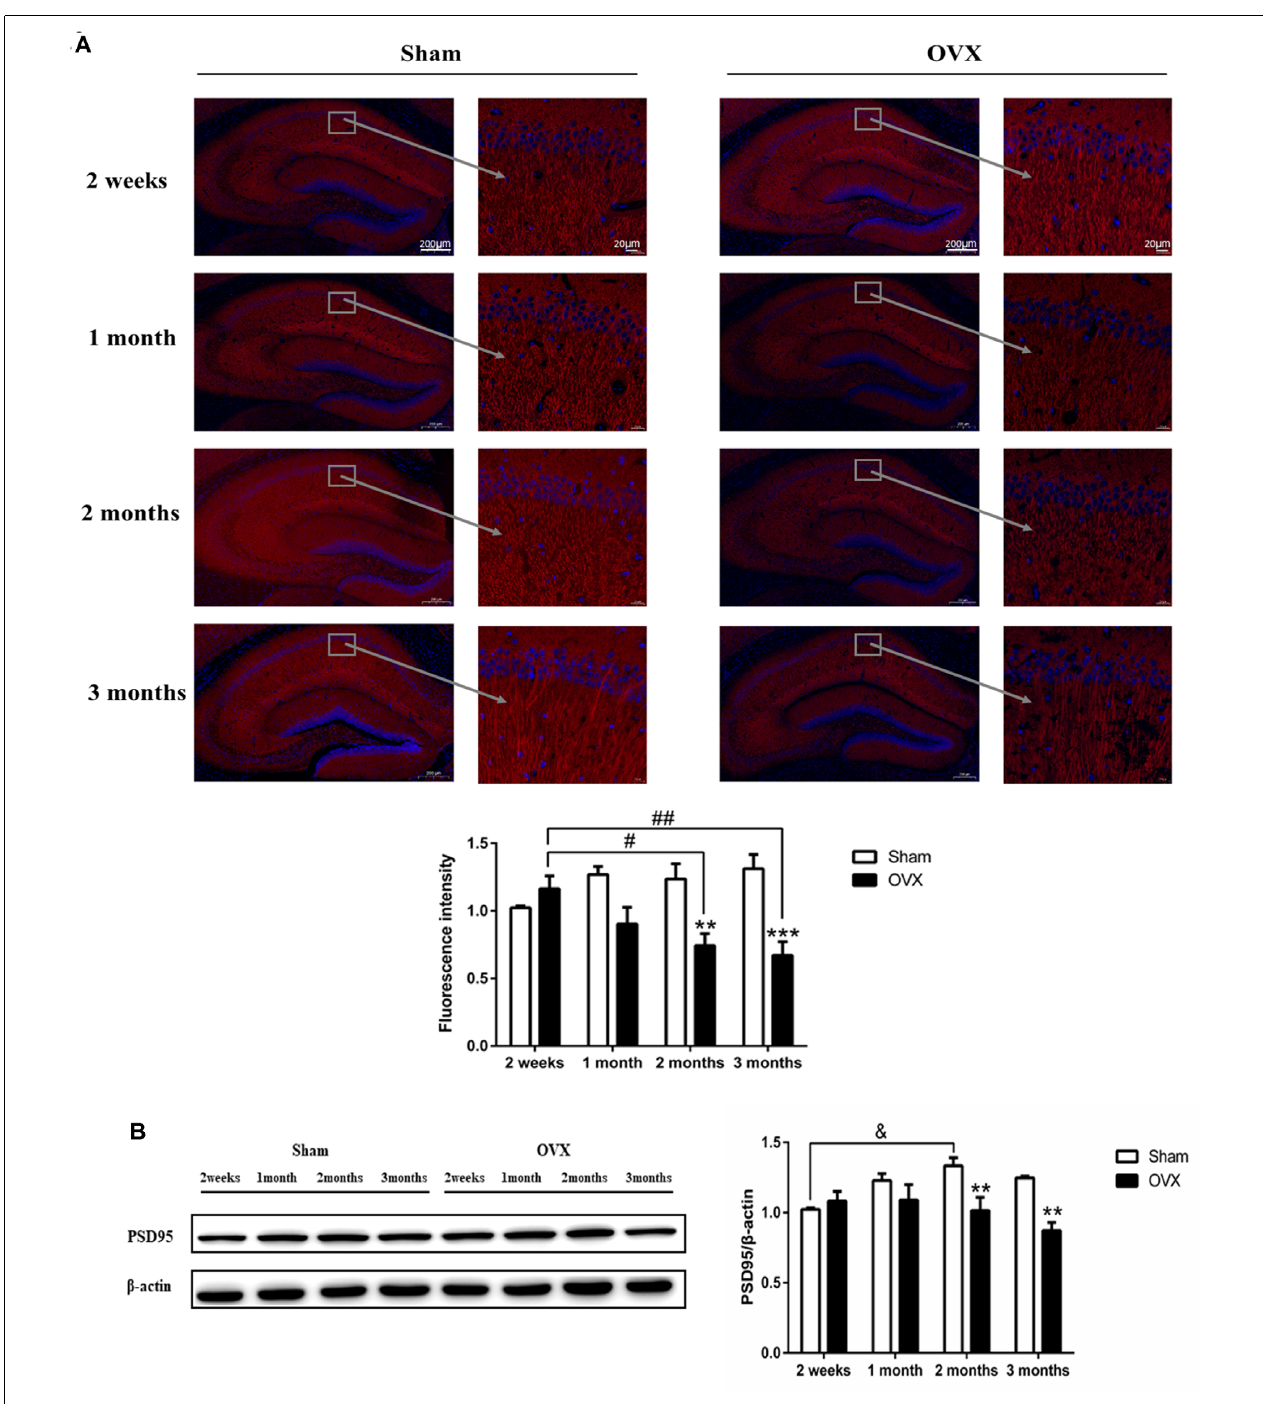
FIGURE 3 | The neuronal structure in the hippocampus CA1 region is damaged in response to ovariectomy (OVX). (A) MAP2 immunofluorescence and quantitation. (B) Immunoblotting analysis of PSD95 and quantitation. Bars represent mean values ± standard error of the mean (SEM). ** p < 0.01, *** p < 0.001 compared with the Sham mice at the same timepoint; & p < 0.05 compared with the 2-week Sham mice; # p < 0.05, ## p < 0.01 compared with the 2 weeks OVX mice ( n = 4).